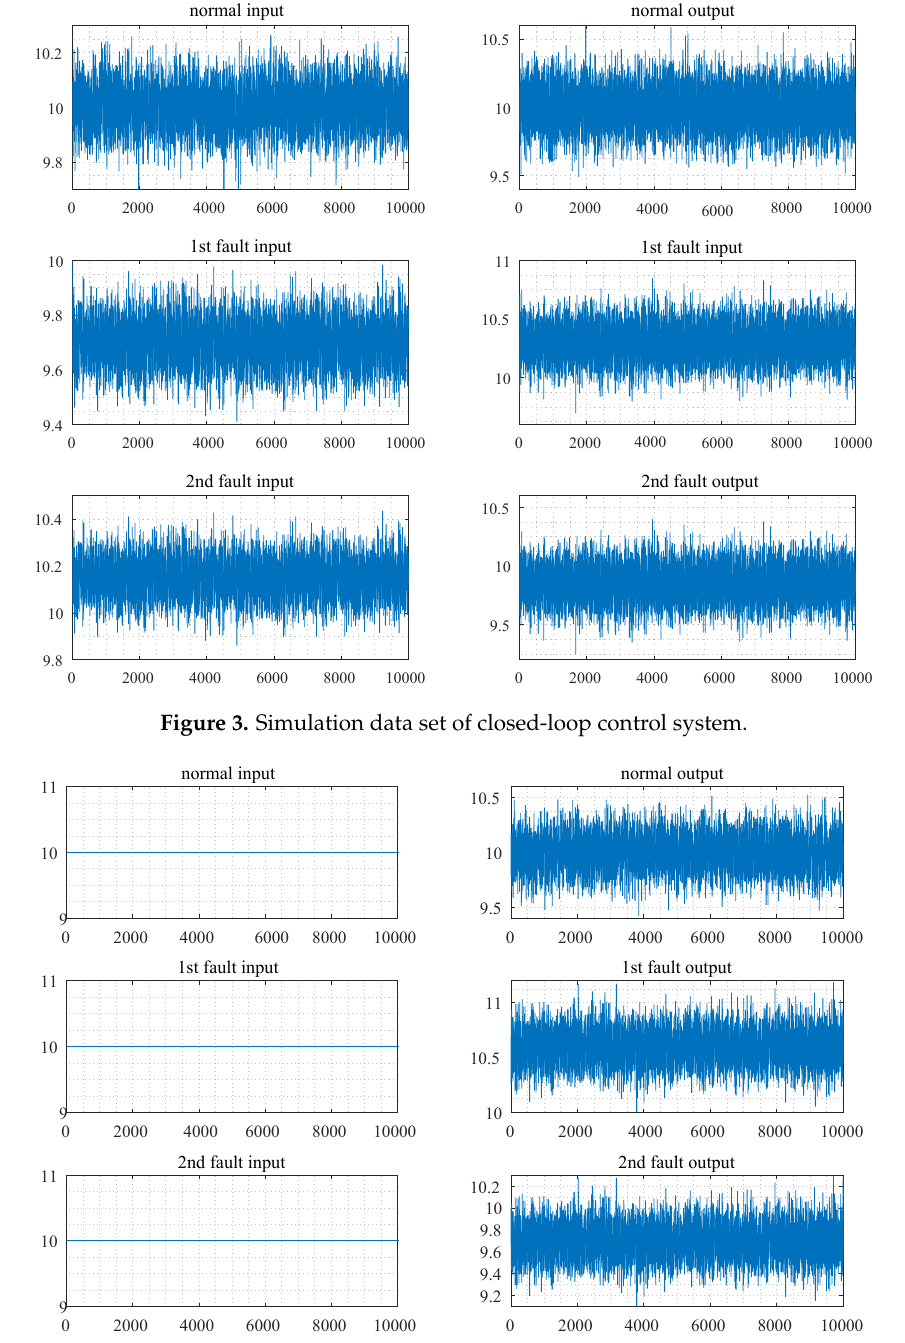
Figure 4. Simulation data set of open-loop control system.